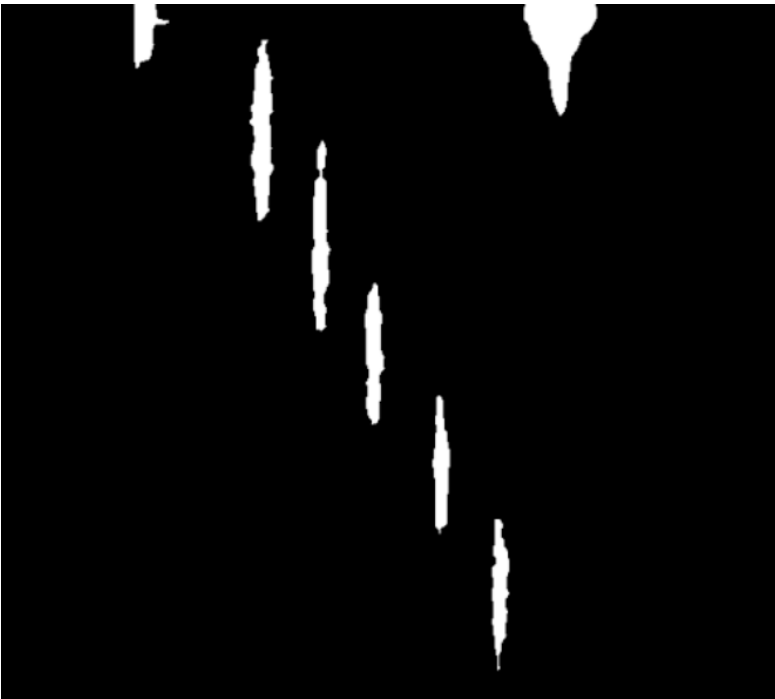
Figure 8. Final image obtained after applying all processing steps